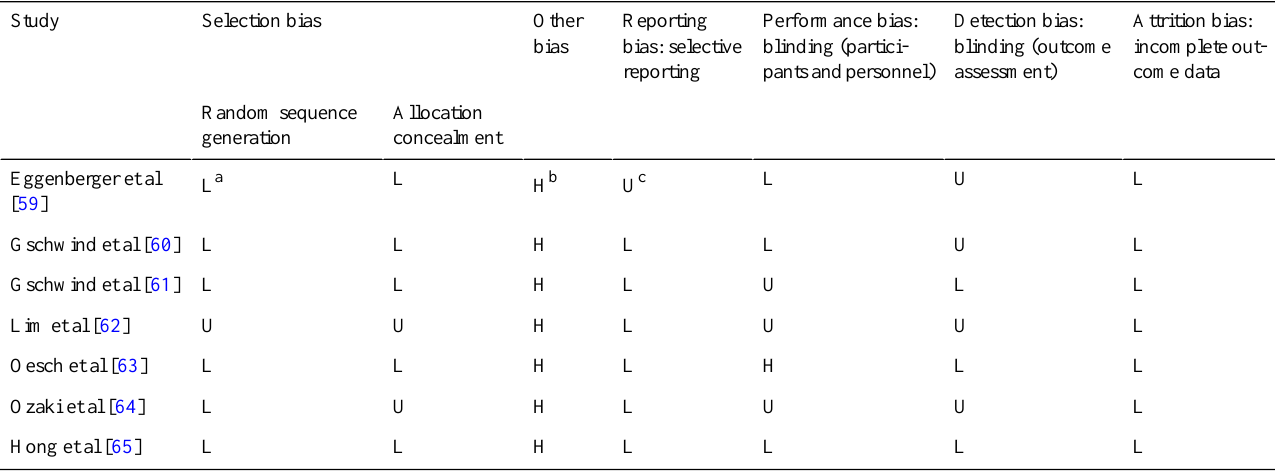
Table 3. Risk of bias for randomized controlled trials based on the modified Cochrane Collaboration